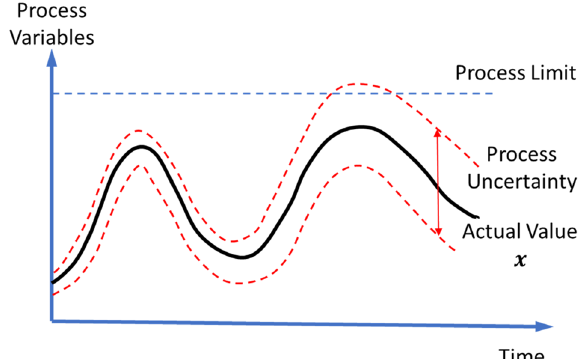
Figure 4. Definition of Process